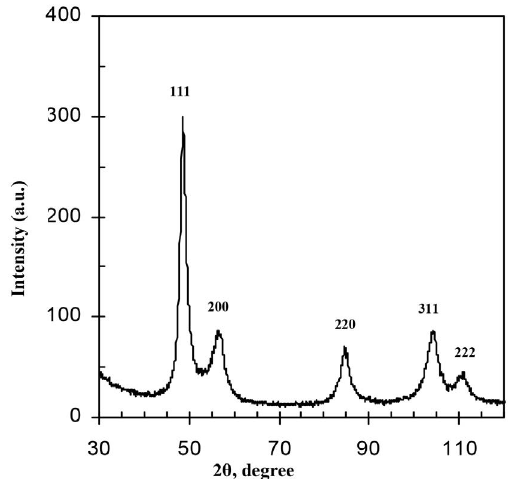
Fig. 1. XRD patterns of silver nanoparticles synthesized with PTHQ usage Ag NPs formed by the reduction of Ag + ions by PTHQ polymer are of the crystalline nature. The average size of the Ag nanoparticles has been calculated from the XRD line width using the Debye-Scherrer equation 23 and was found to be equal 20.8